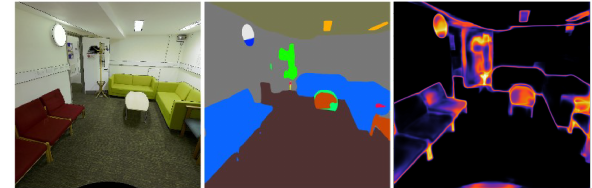
Figure 3. Projected tangential image ( left ), visualisation of UPerNet semantic segmentation classes ( centre ) and corresponding confidence map where darker is more confident ( right